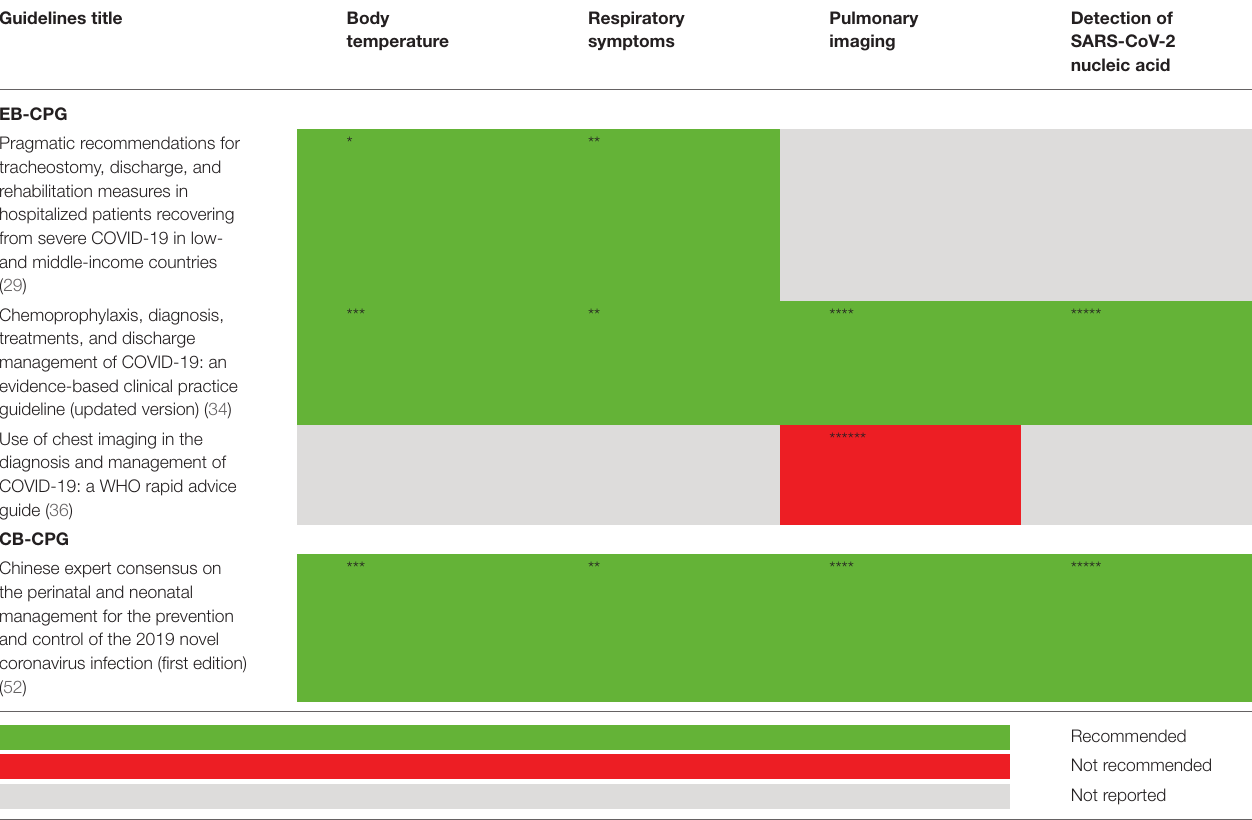
TABLE 5A | Recommendations on discharge criteria of